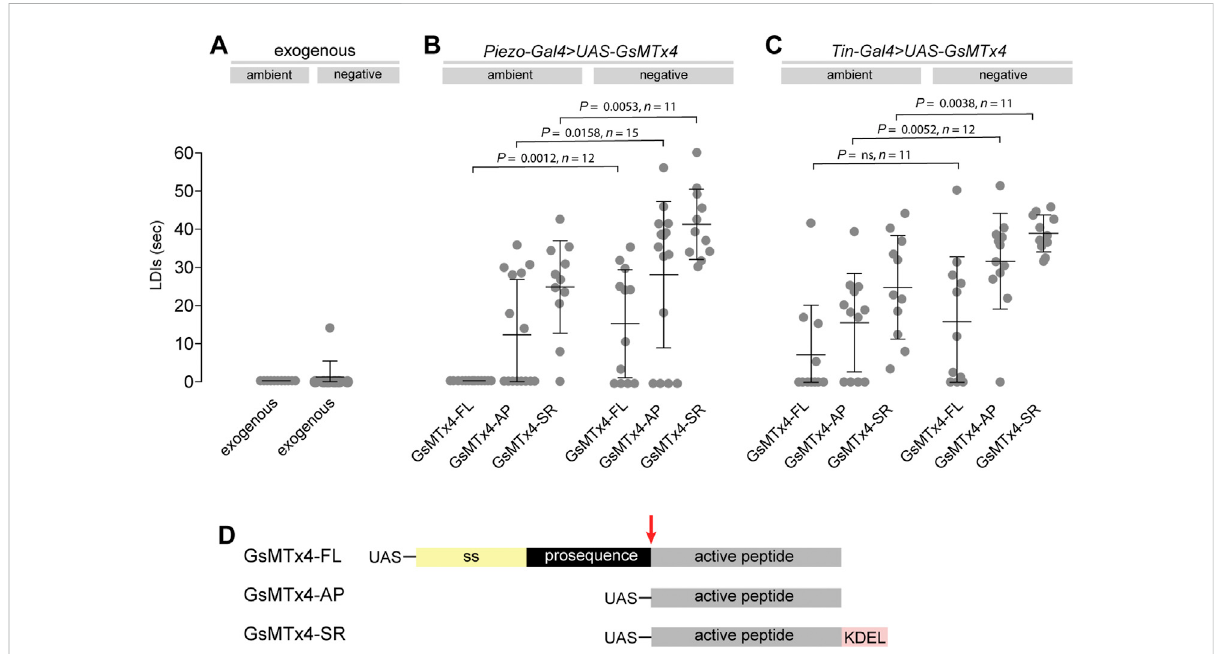
FIGURE 3 Pharmacological inhibition of Piezo causes heart arrest under mechanical stress. (A – C) Quanti fi cation of LDIs with GsMTx-4 applied exogenously (A,5mM; n =12),orwhenexpressedfromatransgenicconstructusing Piezo-Gal4 (B) or Tin-Gal4 (C) ,underconditionsofambientand negative ( − 482 mmHg) pressure. Each data point represents an individual heart preparation; the y -axis shows additive time in LDI over a 60 s period for each individual preparation. p -values, unpaired t-test. (D) Schematic drawing of the GsMTx-4 transgenic constructs used in the study: secreted ( GsMTx4-FL ); non-secreted ( GsMTx4-AP ); SR-targeted ( GsMTx4-SR ). UAS = Upstream Activation Sequence; ss = signal sequence; KDEL = ER/SR translocation signal; red arrow = mature peptide cleavage